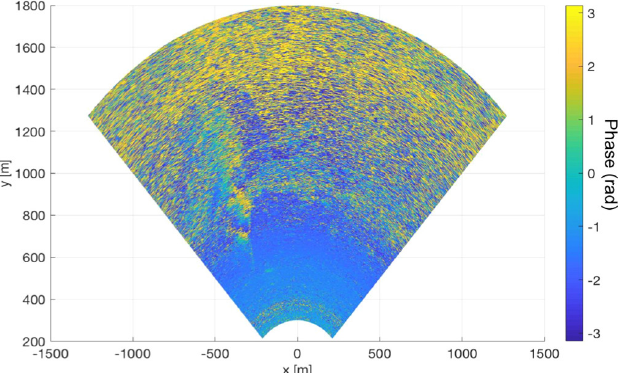
Figure 20. Radar image obtained with 33% of data and CS. In order to evaluate the interferometric error, we have processed 41 measurements acquired in 4 hours and 20 min. By considering one pixel associated to one stable point (without visible fringes),